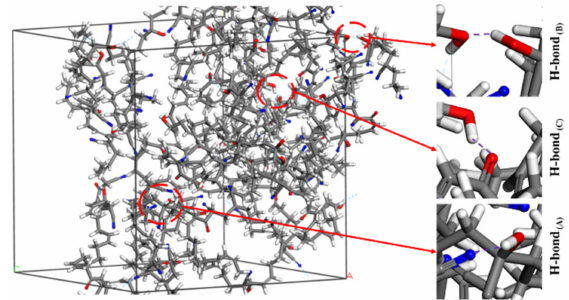
Figure 8. Three types of H-bond in OH-CO-NBR